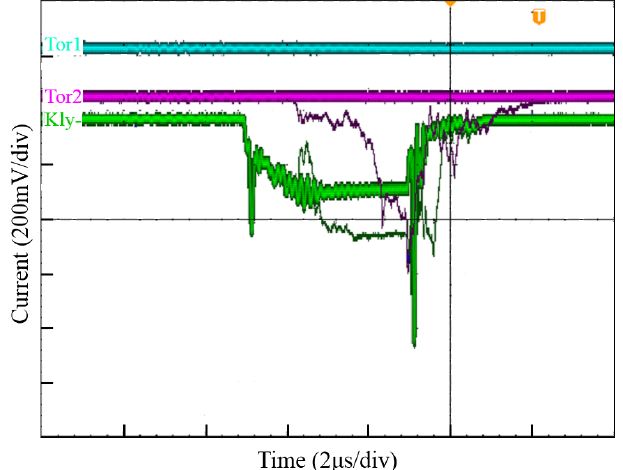
during high-power conditioning. Tor1: readout of the FCT1; Tor2: readout of the FCT2; Kly-: reflected power to the klystron. The unit of the ordinate only applies for the Tor1 and Tor2